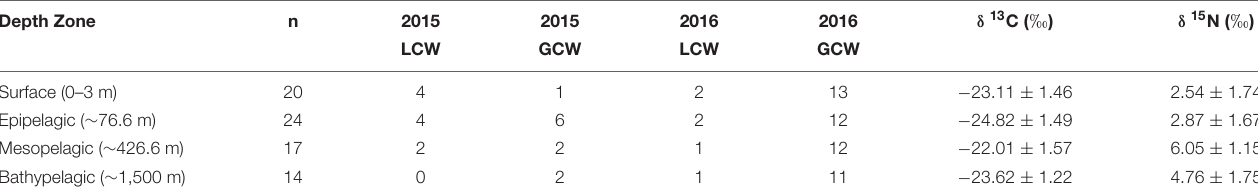
TABLE 2 | Summary table depicting sample totals of particulate organic matter for each sampling period and mean ( ± SD) δ 13 C, δ 15 N, and C:N values for each depth zone. Depth